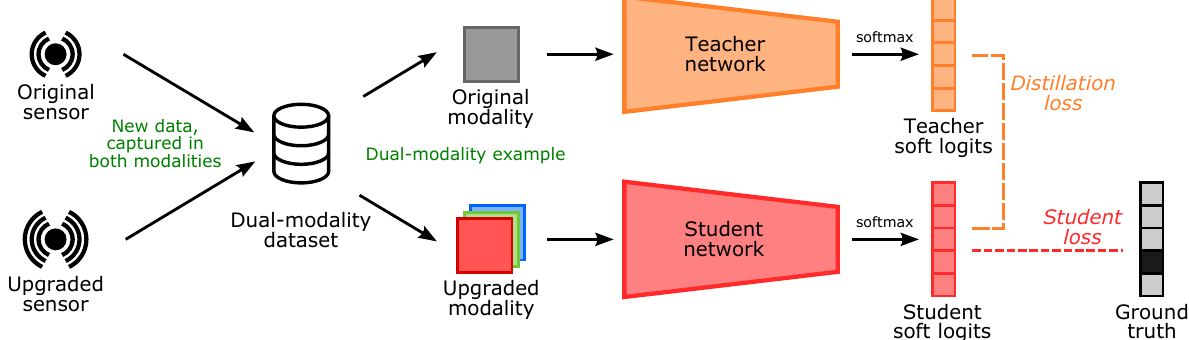
Figure 1. Upgrading to a new sensor. During transition, a small dataset is captured using both sensors. Using this dataset, a student network is trained on the new data modality, with the help of the original network, now functioning as